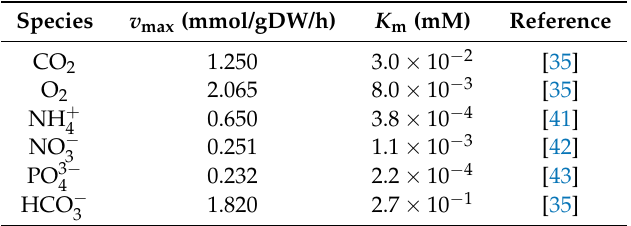
Table 5. Michaelis-Menten parameters for uptake rates of key species in Figure